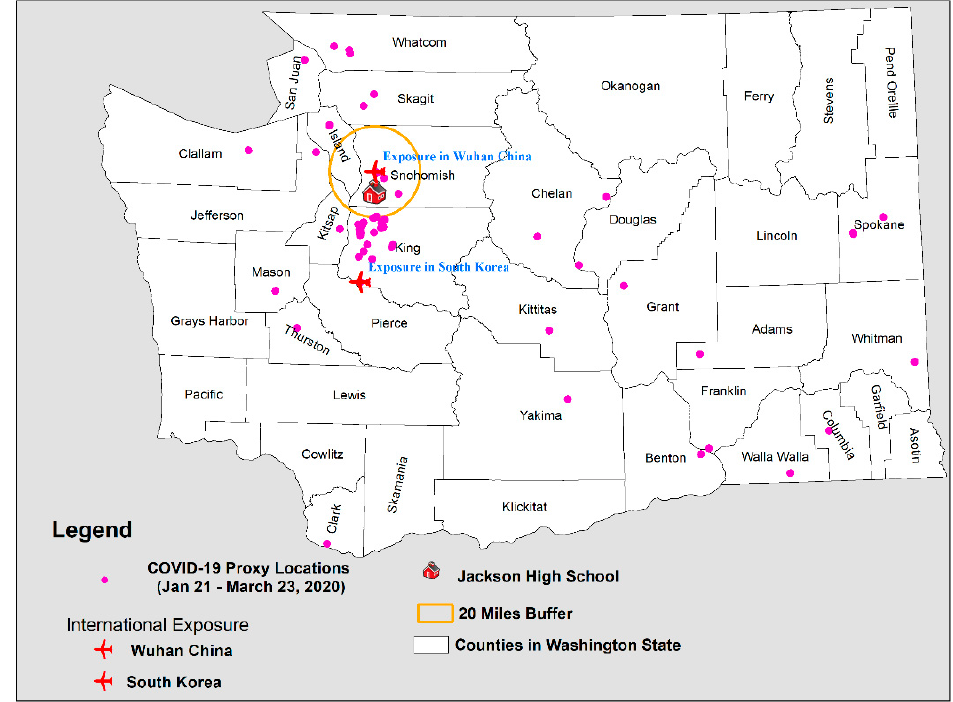
Figure 7. Proxy locations of two patients infected during international travel and their proximity to